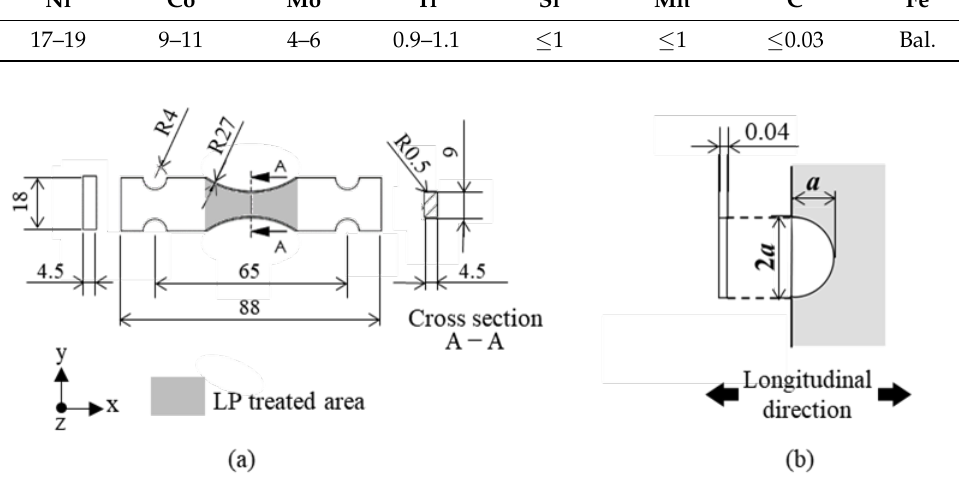
Figure 1. Shapes and dimensions of ( a ) the bending-fatigue test specimen and ( b ) the semicircular slit.